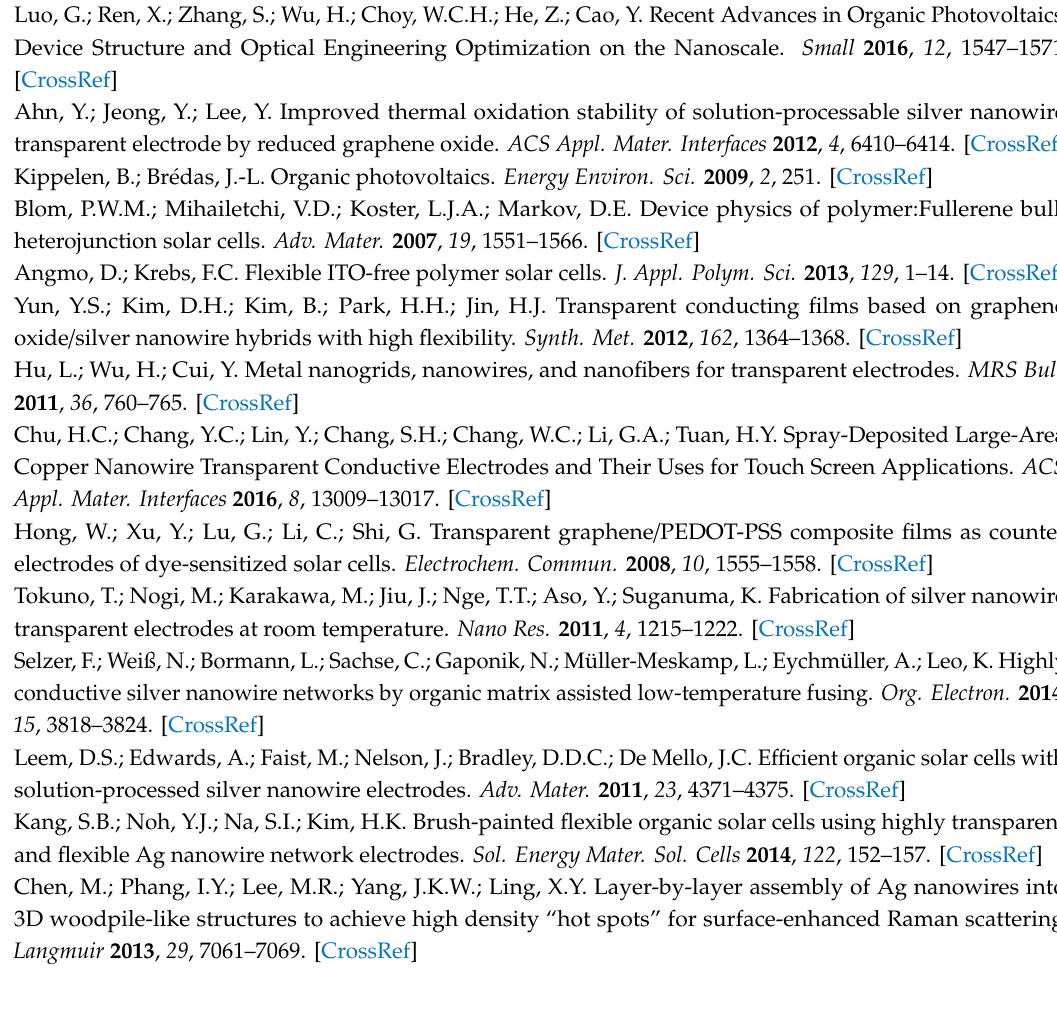
Figure S1: XRD pattern of the silver nanowires. Figure S2: SEM images of 3 bilayer AgNW films a) with PDT, washed and dried, b) without PDT, unwashed and only dried, c) without PDT washed and dried for 3h deposition time. Table S1: Sheet resistance, optical transmittance and FOM values of LBL assembled AgNW electrodes. Table S2: Comparison of the sheet resistance, optical transmittance and FOM values of our work with previous